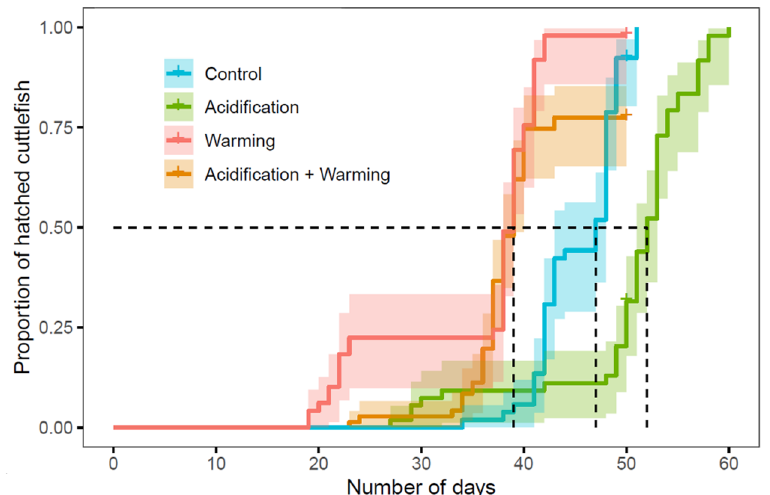
Figure 1. Proportion of cuttlefish that hatched over time (from the start of acclimation, integrating development time and hatching success), related to different treatments: control, acidification, warming, and acidification and warming. The dotted lines indicate the day at which 50% of cuttlefish were born in each treatment.